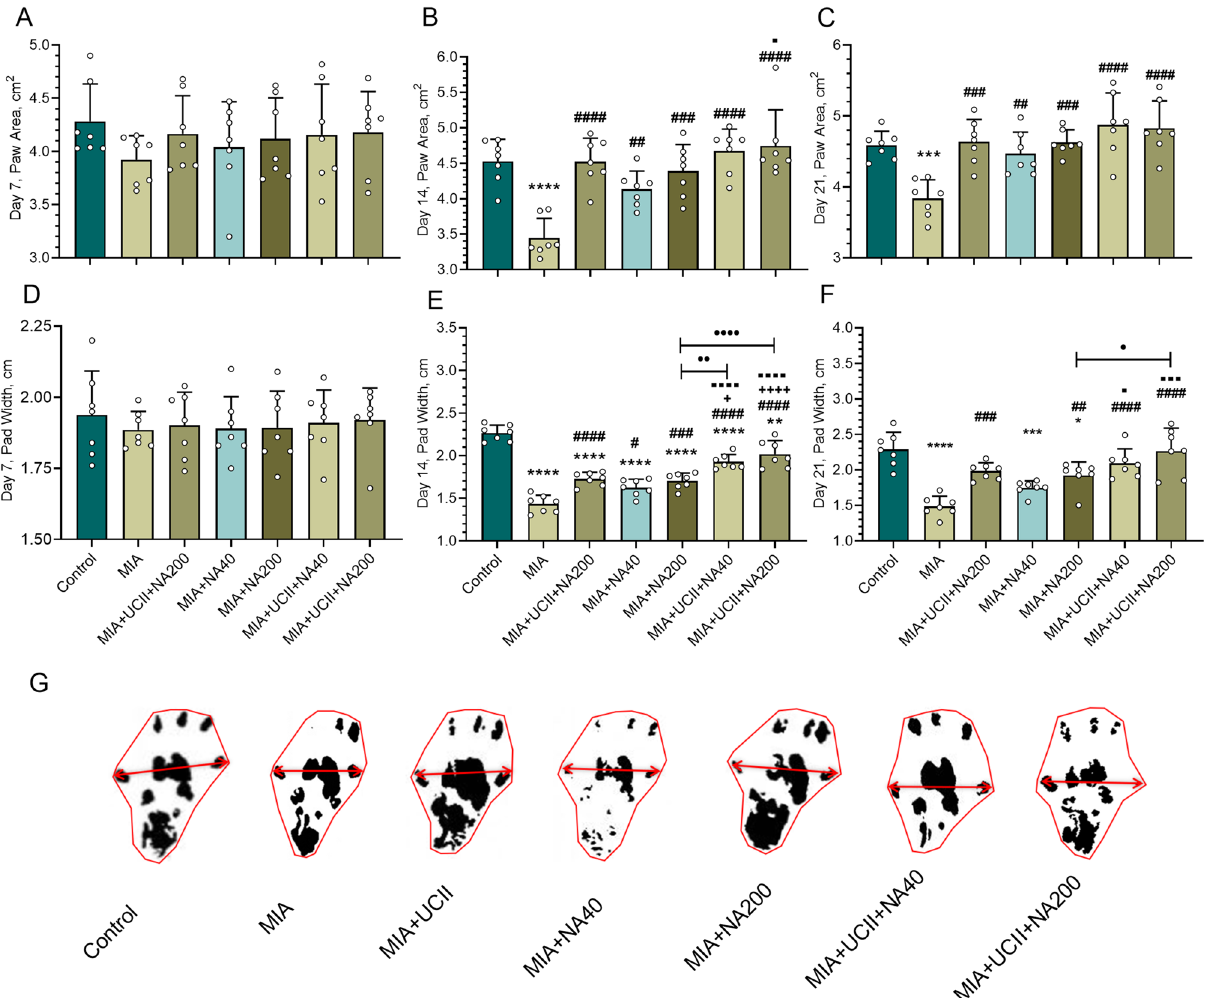
Figure 2. Effects of niacinamide (NA) and undenatured type II collagen (UCII) supplementation on paw area [on days 7 ( A ), 14 ( B ), and 21 ( C )] and pad width [on days 7 ( D ), 14 ( E ), and 21 ( F )] in monosodium iodoacetate (MIA)-induced osteoarthritis in rats (n = 7). Representative images of the paw area and pad width measured on day 21 of the study are shown ( G ). Control as a non-supplemental group with no osteoarthritis- induced rats, MIA as a non-supplemental group with monosodium iodoacetate (MIA)-induced knee osteoarthritis, MIA + UCII as MIA group gavage-fed a supplemental UCII at 4 mg/kg, MIA + NA40 as MIA group gavage-fed supplemental niacinamide (NA) at 40 mg/kg, MIA + NA200 as MIA group gavage-fed a supplemental NA at 200 mg/kg, MIA + UCII + NA40 as MIA group gavage-fed both supplemental UCII at 4 mg/ kg and NA at 40 mg/kg, and MIA + UCII + NA200 as MIA group gavage-fed both supplemental UCII at 4 mg/ kg and NA at 200 mg/kg. Oral gavage delivery of supplements was applied from d7 to d30. ANOVA and Tukey’s post-hoc test were used for comparing the results among different treatment groups. Statistical significance between groups is shown by: * p < 0.05; ** p < 0.01; *** p < 0.001; **** p < 0.0001 compared as Control group and, # p < 0.05; ## p < 0.01; ### p < 0.001; #### p < 0.0001 compared as MIA group and, + p < 0.05; ++++ p < 0.0001 compared as MIA + UCII group and, ⬛ p < 0.05; ⬛⬛⬛ p < 0.001; ⬛⬛⬛⬛ p < 0.0001 compared as MIA + NA40 group